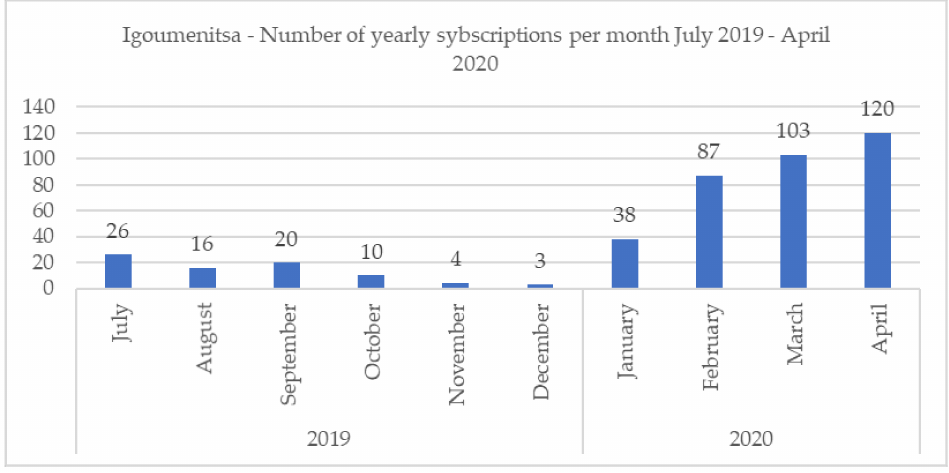
Figure 2. Evolution of the number of yearly subscriptions per month for the time period